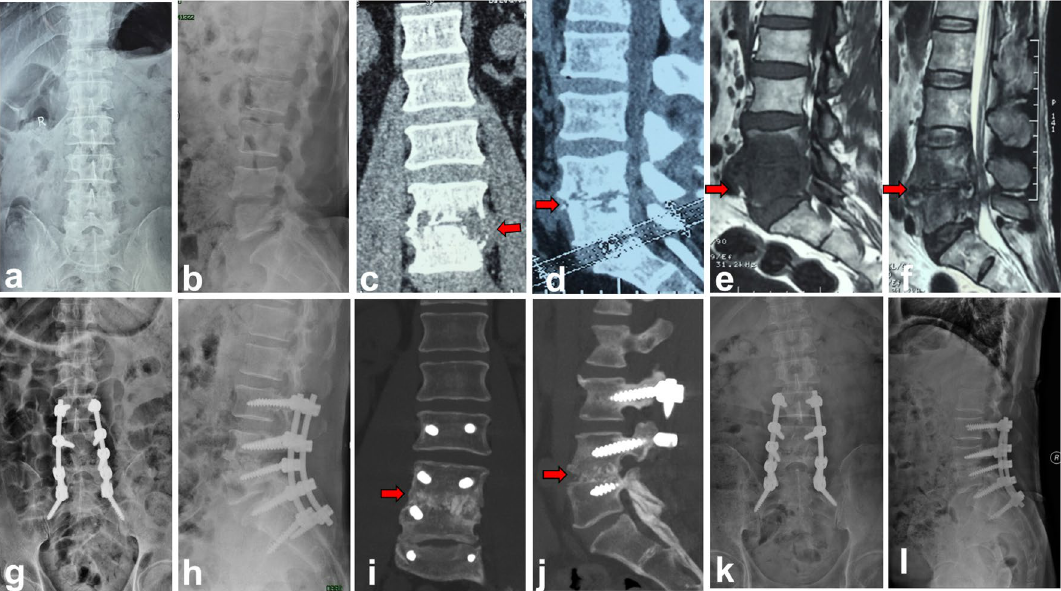
Figure 4. Autologous spinous process group (group B). A 62-year-old male with L4–5 lumbar pyogenic spondylitis. ( a – f ) Preoperative MRI and CT showed there were bone destruction, intervertebral space stenosis and massive paravertebral abscess (red arrow) at L4–5. ( g , h ) Postoperative X-ray showed autologous spinous process, screws and rods were in good location. ( i – l ) CT taken at 5 months after operation showed solid bone fusion between L4 and